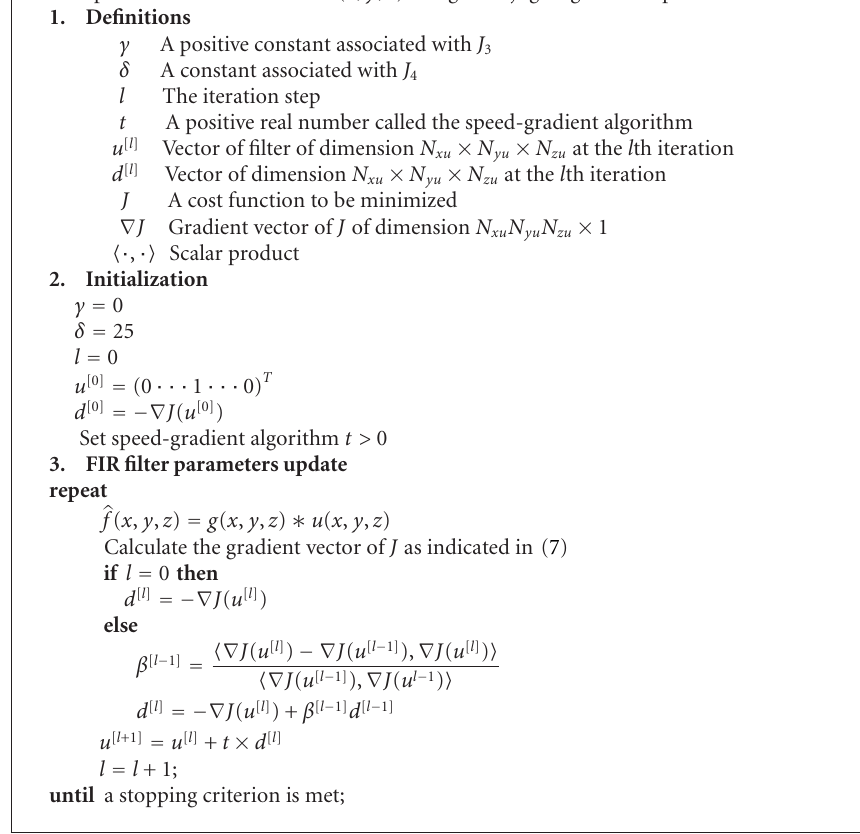
Algorithm 1: NAS-RIF